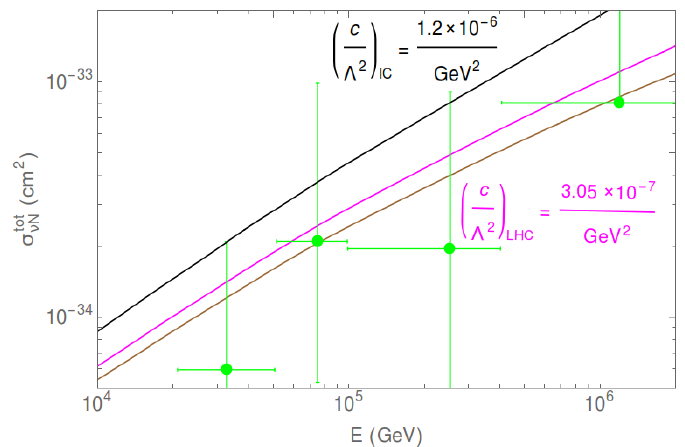
Figure 5 . The maximum allowed values of NC neutrino-nucleon cross-section in presence of NSI appearing in eq. (4.5). Colour coding is the same as in (cid:12)gure 1.